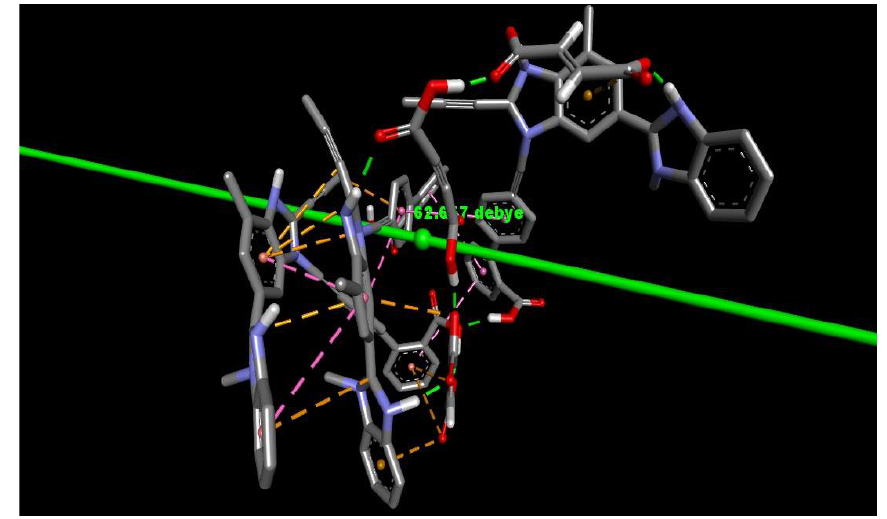
Figure 5. Force of interactions between TEL, MAL and MALION.